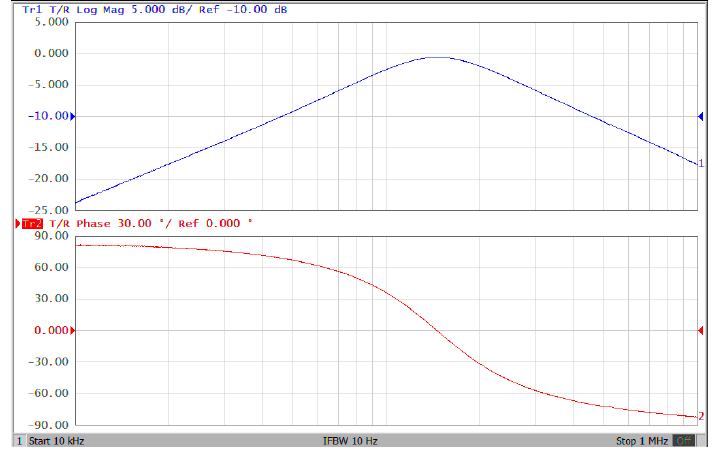
Figure 35. Experimentally observed gain and phase responses of the BP filter realized in case II.